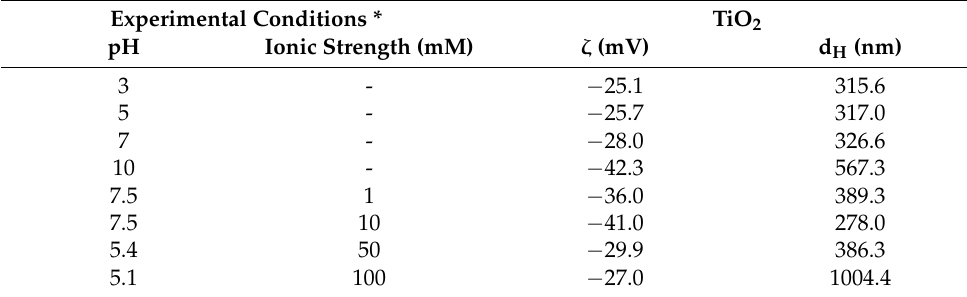
Table 1. Zeta potential and hydrodynamic diameter for TiO 2